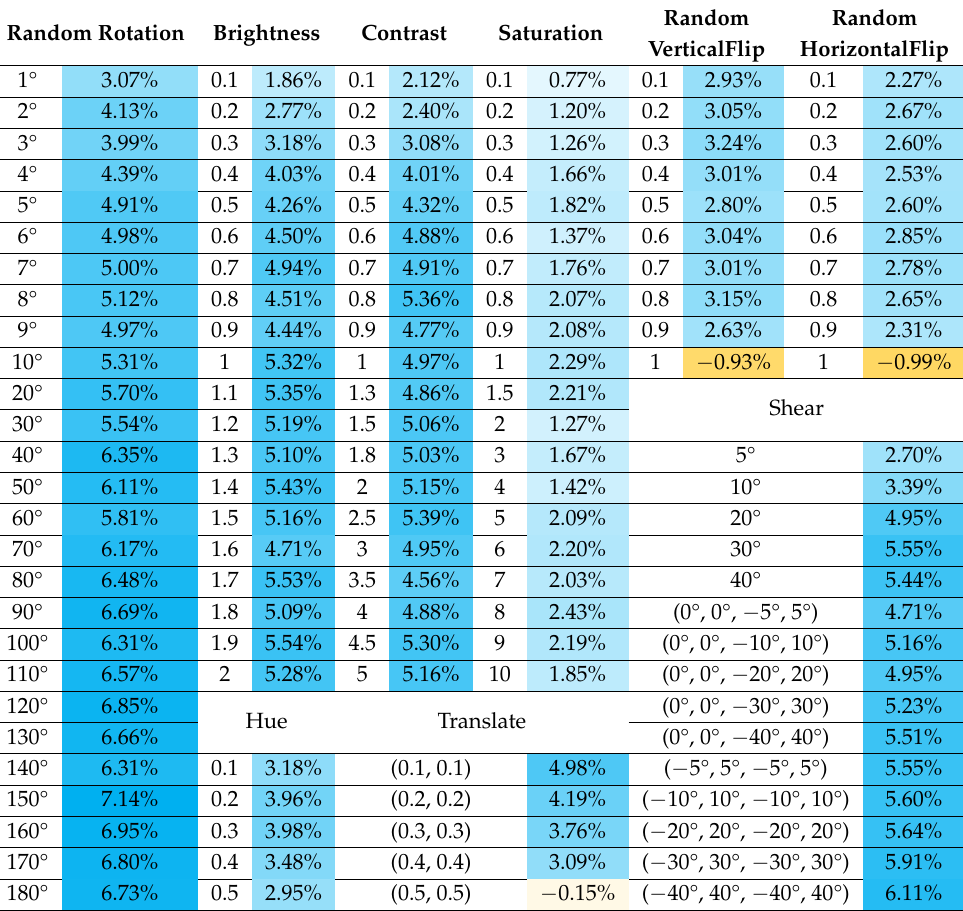
Table 6. Performance of DA methods on Γ train 50 . The impact of different DA methods and parameters CCZ on Γ train 50 classification performance is displayed. The displayed percentage values describe the CCZ increase/decrease of mAA in percent. The value is color-coded from blue (increase in accuracy) over white (no effect) to orange (decrease in